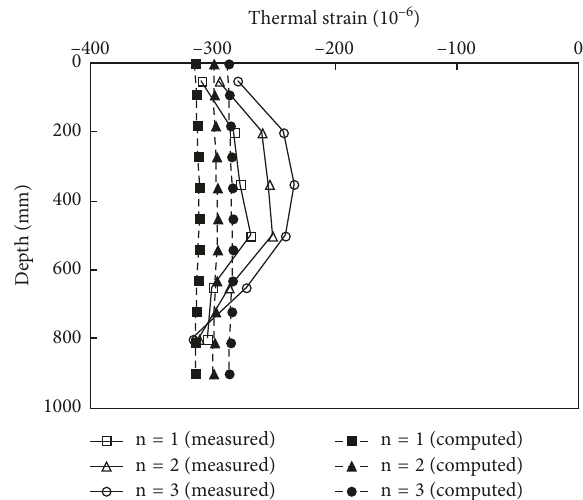
Figure 9: Thermal strain